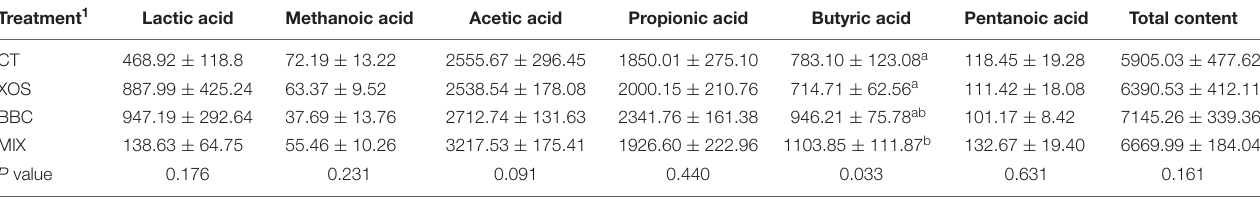
TABLE 4 | The effect of XOS and Pediococcus acidilactici BCC-1 supplementation on the production of lactic acid and SCFA in cecum chyme of broilers on d 21 (mmol/g). Treatment